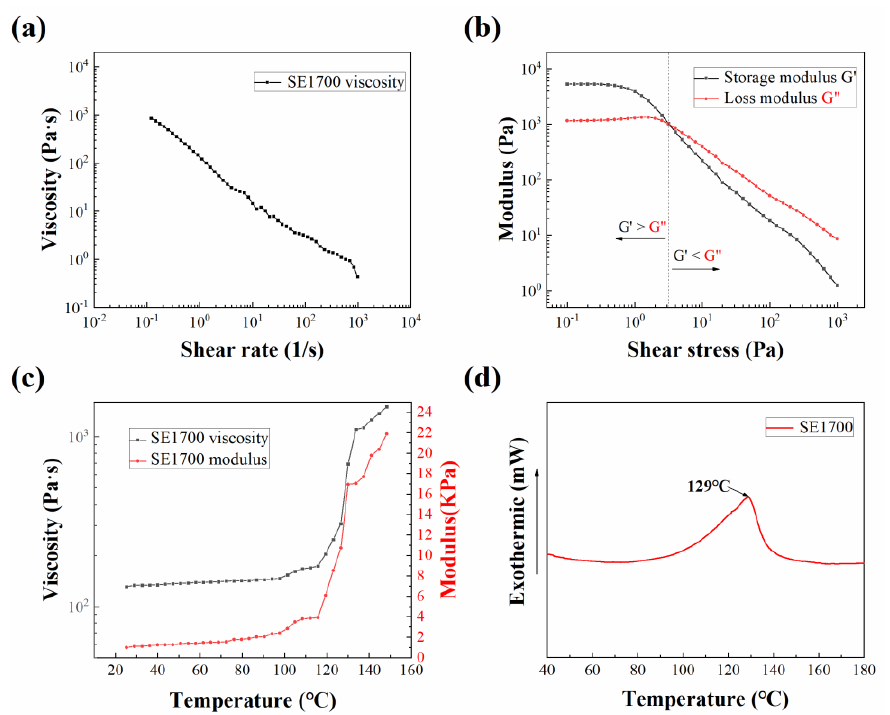
Figure 1. Characterization of properties of polydimethylsiloxane (PDMS): ( a ) viscosity-shear rate profile; ( b ) storage/loss-shear stress profiles; ( c ) temperature-viscosity/temperature-modulus profiles; ( d ) differential scanning calorimeter (DSC) profile.